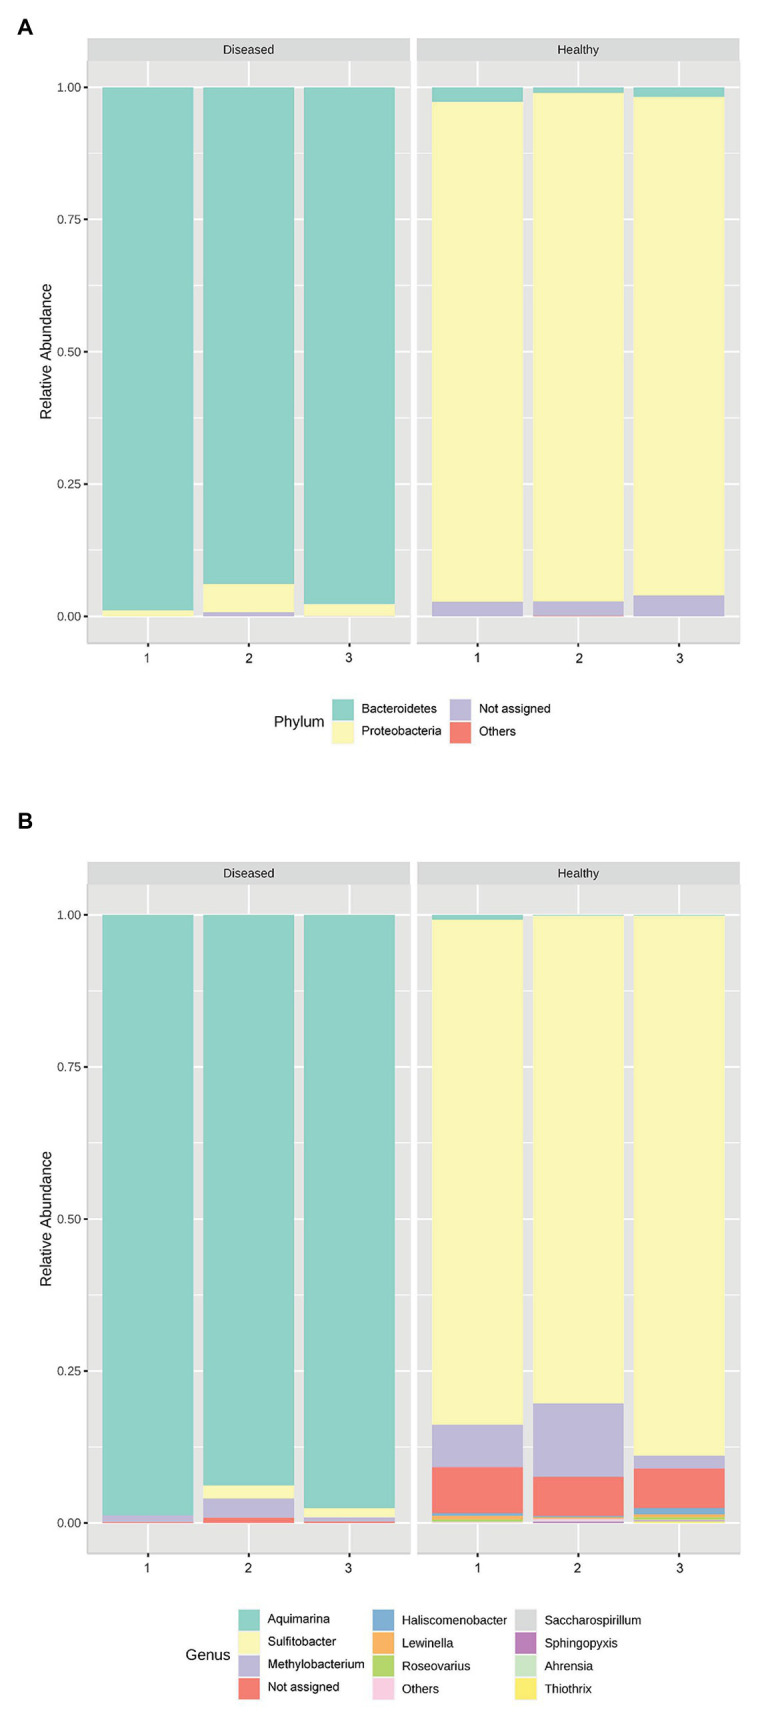
Relative abundance of the bacterial (A) phyla and (B) genera in the pereiopods of P. ornatus phyllosomas (n = 3 per treatment group).